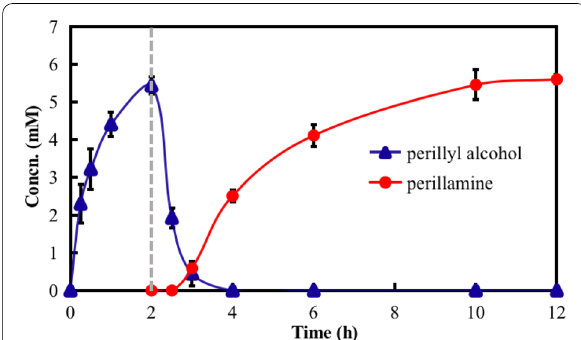
Fig. 3 Time course of the 100‑mL preparative‑scale multi‑enzyme cascade reaction. Step I: 10 mM (